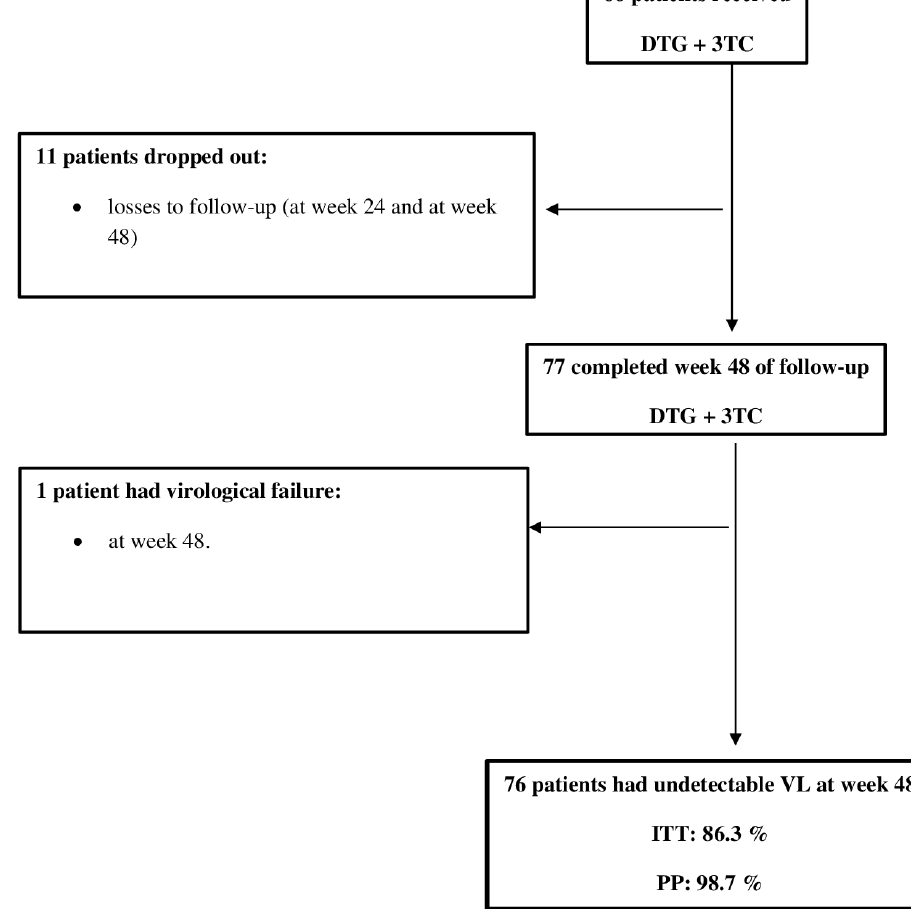
Figure 1. Flowchart of patients treated with dolutegravir (DTG) plus